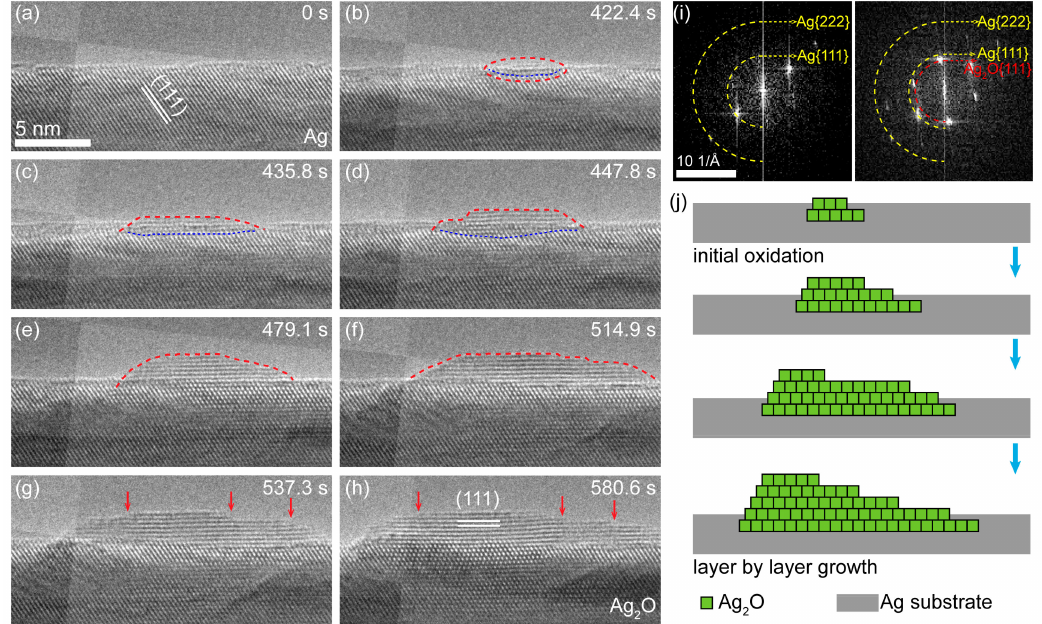
Figure 2. Layer-by-layer growth of Ag 2 O on the Ag nanowire surface. ( a – h ) Time sequenced HRTEM images showing the growth process of Ag 2 O grain. The red arrows show the step edges of the layer, and blue dashed lines indicate the interface between Ag and Ag 2 O. Dose rate at 10,700 e · Å − 2 · s − 1 . ( i ) Corresponding FFT pattern analysis indicating the Ag 2 O formation during the surface oxidation. ( j ) Schematic diagram showing the layer-by-layer growth of Ag 2 O